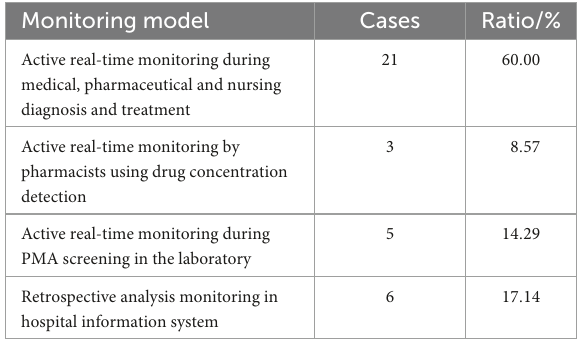
TABLE 4 Prescription medication distribution of reported